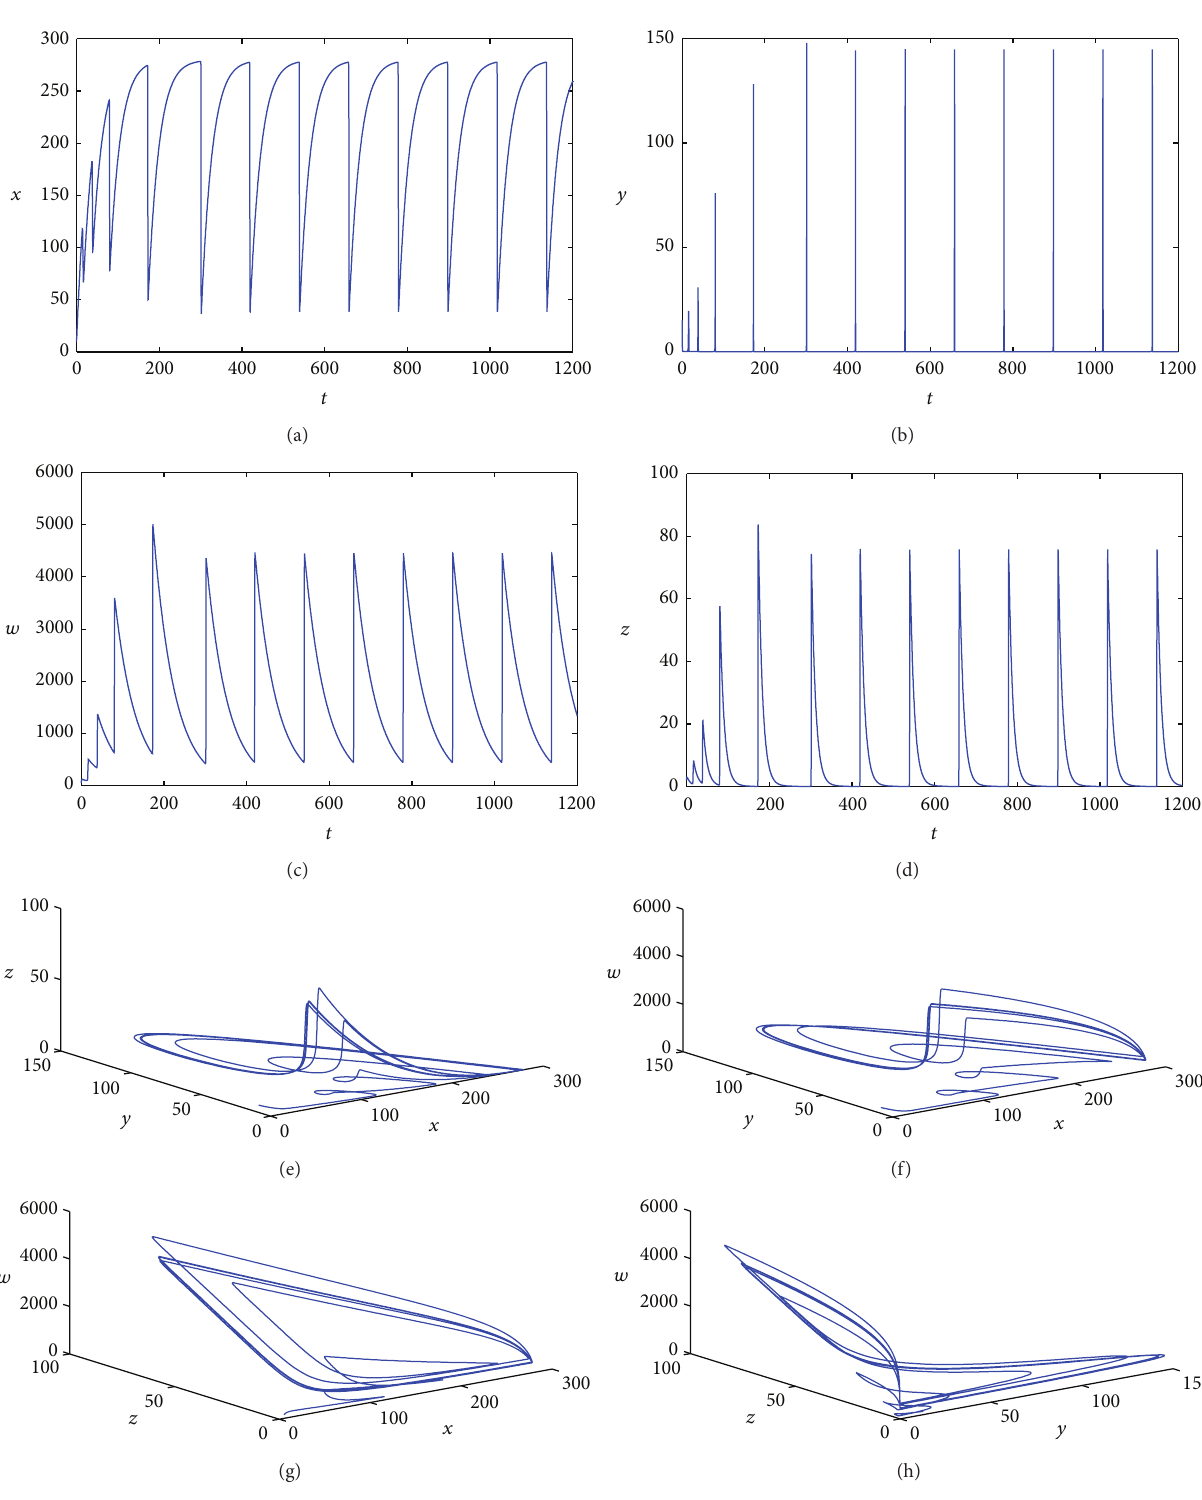
Figure 4: It shows the numerical simulations of model (4), when the efficacy rate of antiretroviral treatments is considered to be low; that is, 𝜖 = 0.2 and 𝜂 = 0.2 . It shows that the equilibrium E + of the model undergoes Hopf bifurcation with oscillatory behavior in solutions even though the delay value is less than the critical value (𝜏 = 0.4 < 𝜏 0 )